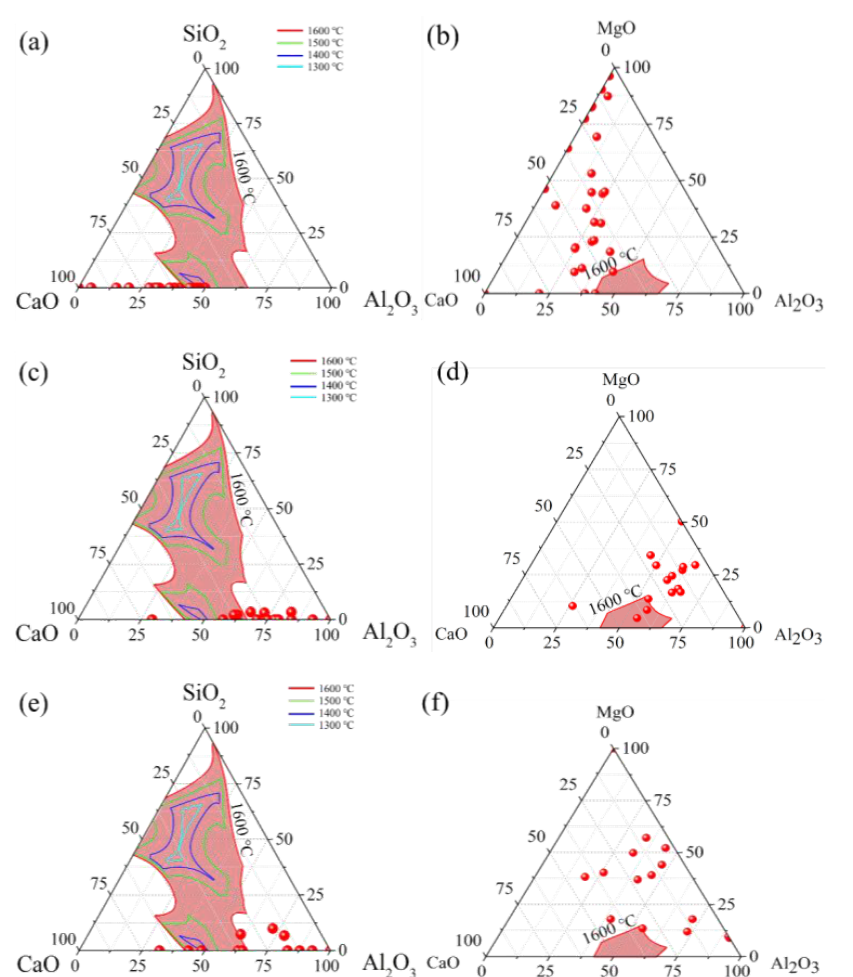
Figure 4. Composition distribution of inclusions in scheme A. ( a ) A-S2; ( b ) A-S2; ( c ) A-S3; ( d ) A-S3; ( e ) A-S4; ( f ) A-S4.